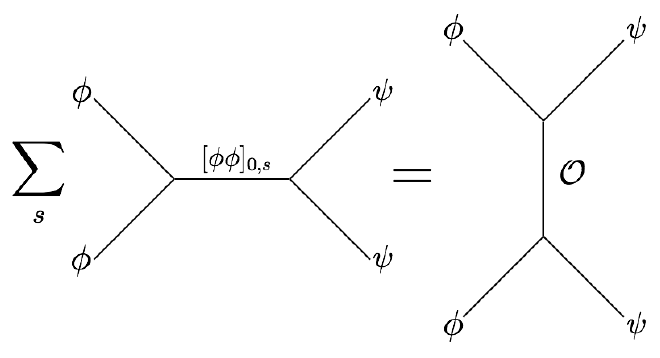
Figure 1 . s = t crossing equation for c